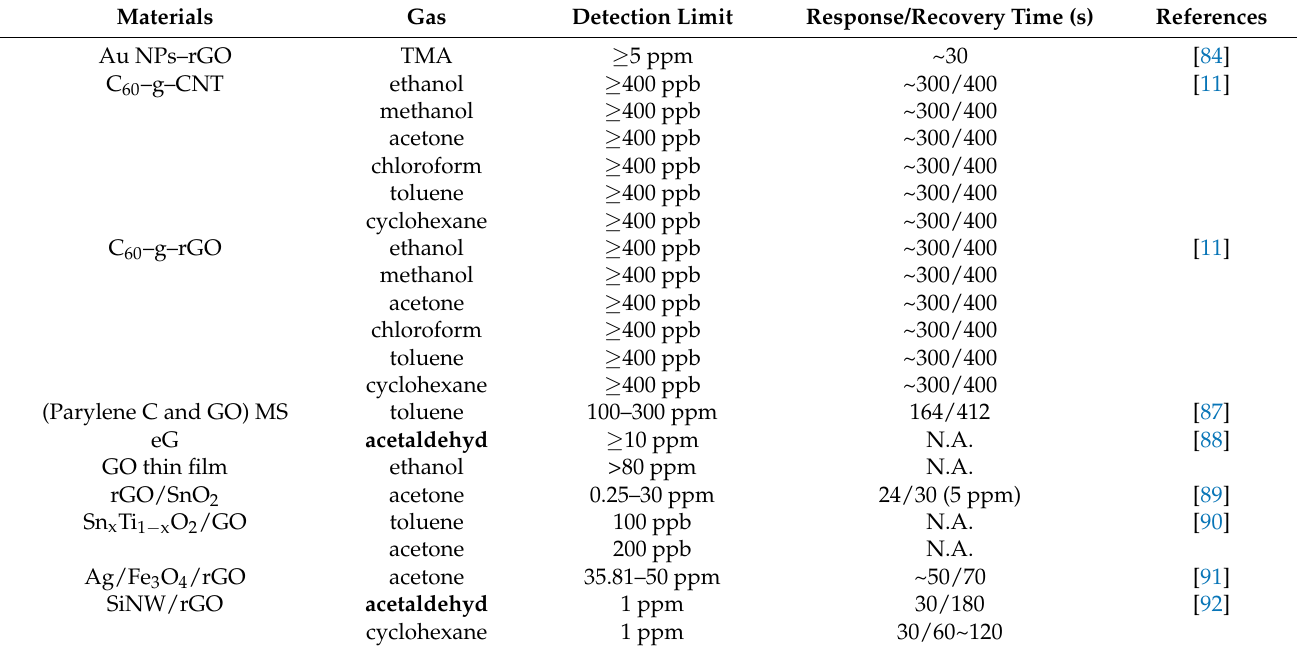
Table 4. The detection range and response/recovery time of graphene composite materials to VOC